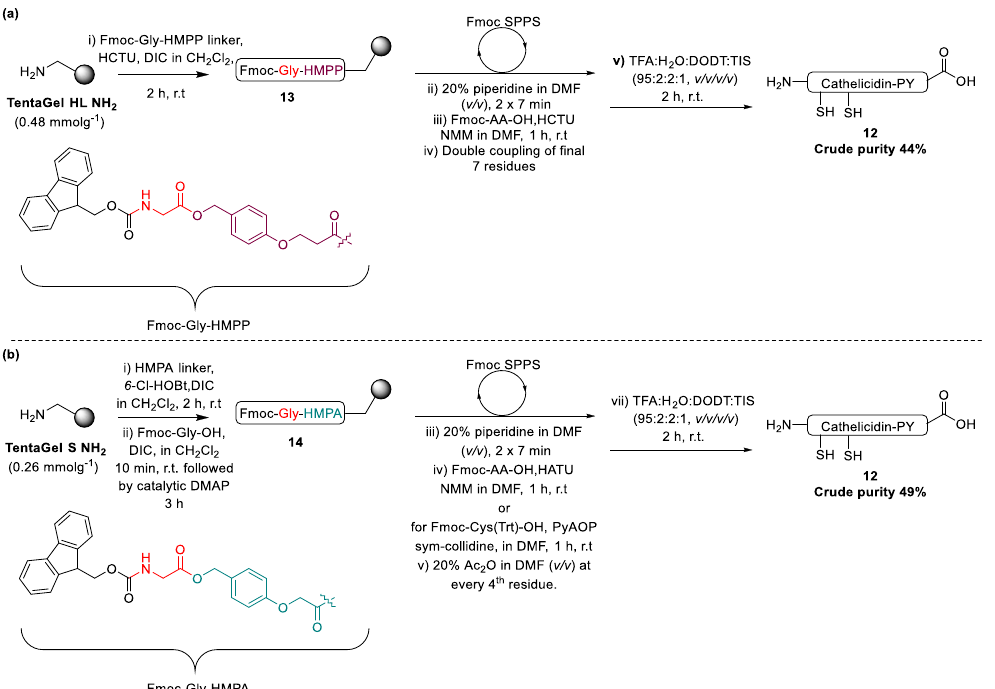
Scheme 2. Synthesis of linear cathelicidin-PY on automated synthesiser using different resin substi- tutions ( a ) TentaGel HL NH 2 (0.48 mmolg −1 ) and ( b ) TentaGel S NH 2 (0.26 mmolg − 1 ); 6 − Cl − HOBt